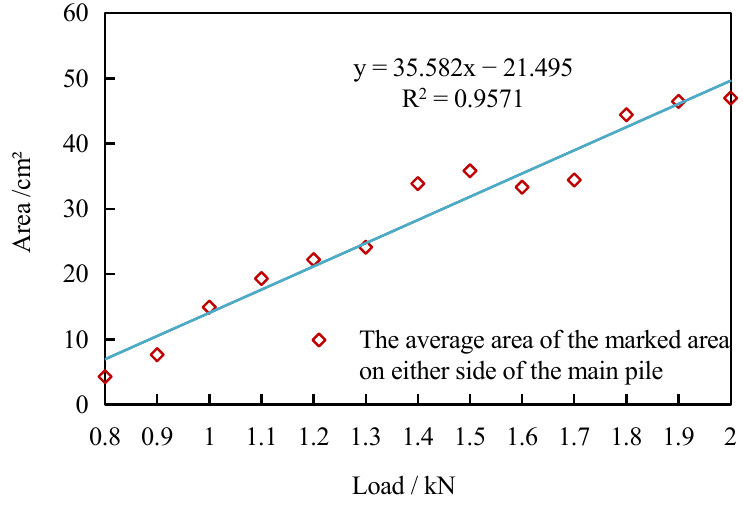
Figure 13. The average area of marked areas on both sides of the pile under different loads.